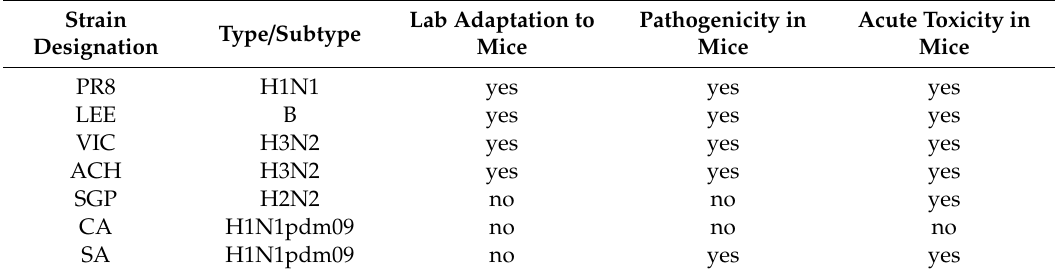
Table 1. Viruses used in this